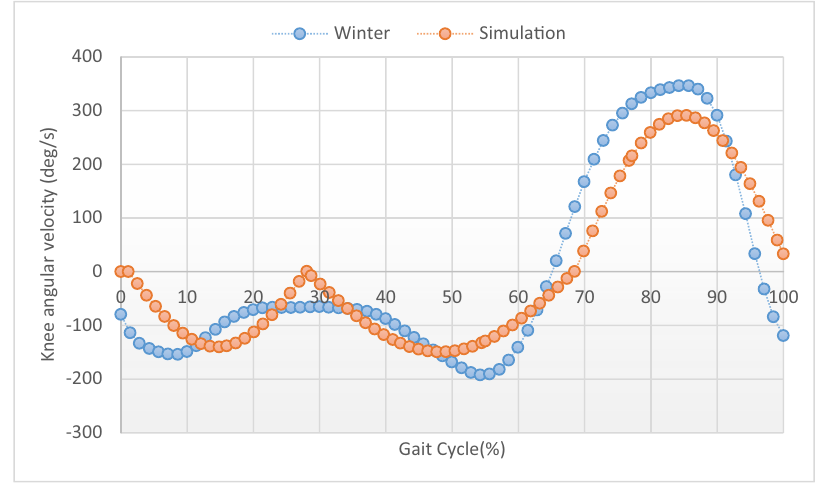
Figure 19: Knee joint angular velocity versus gait cycle.